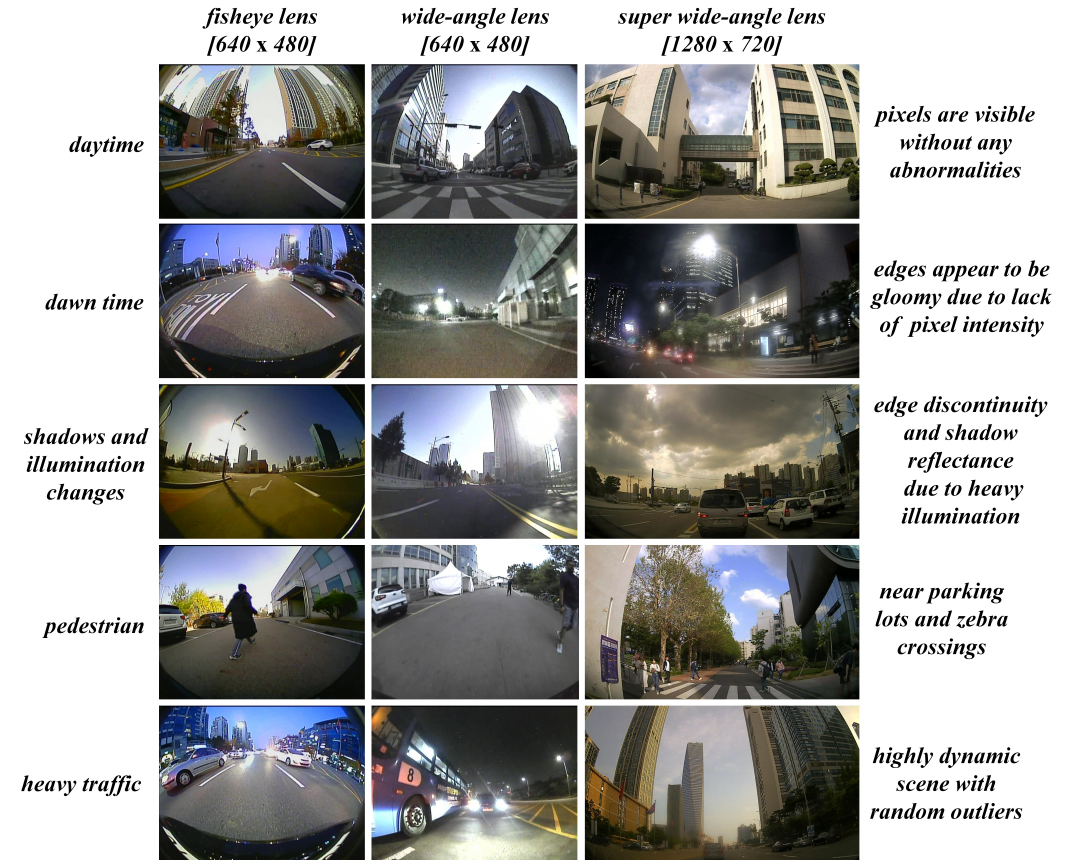
Figure 12. Data acquisition scenarios using various camera